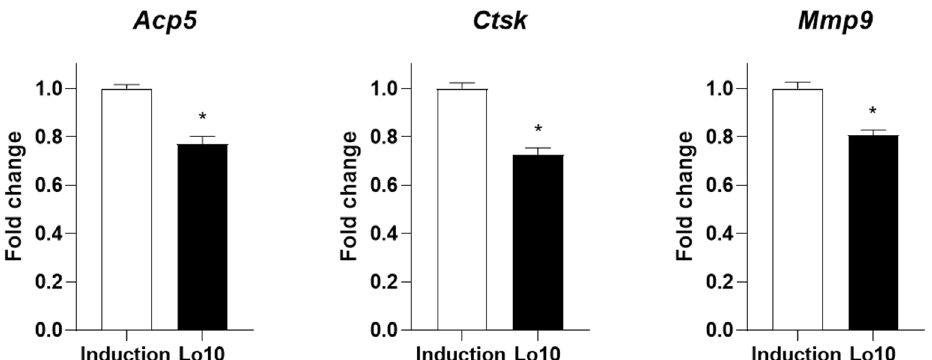
Figure 4. Effects of loganin on osteoclast-specific markers in mouse bone marrow monocytes. Bone marrow monocytes were incubated in osteoclast induction medium (50 µ g/mL of M-CSF and 50 µ g/mL of RANKL) with 10 µ M loganin for 5 days. mRNA expression levels of osteoclast-specific markers including Acp5 , Ctsk , and Mmp9 were determined by qRT-PCR. Lo10: loganin 10 µ M. * p < 0.05 vs. induction (Student’s t -test).